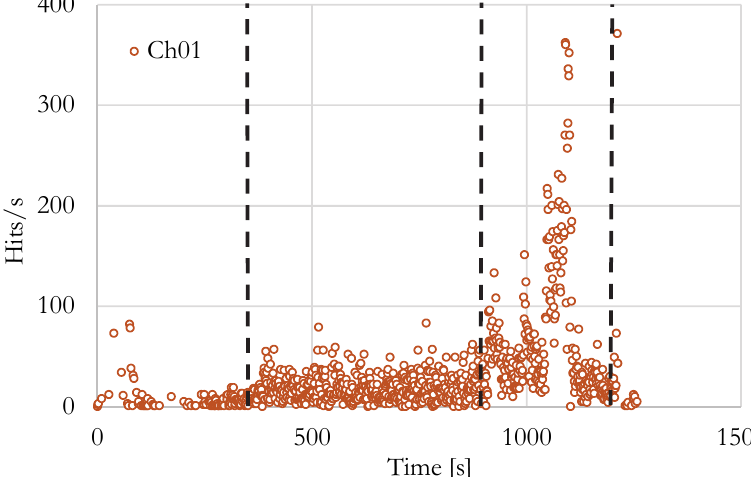
Figure 12: The time variation of the hits/s and the time intervals considered